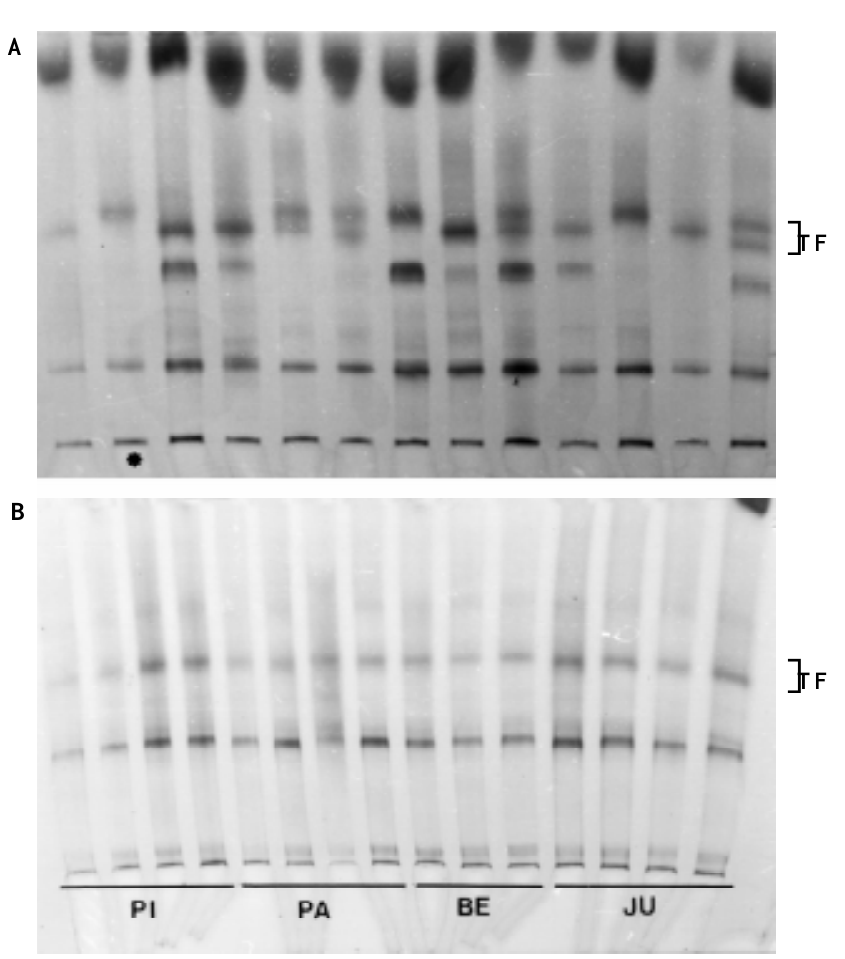
Figure 1 - Electrophoretic patterns of transferrin (TF). A , Allelic variability detected in the Pentecoste stock; *speci- men from the Pirassununga stock. B , Monomorphism detected at Pirassununga (PI), Pacatuba (PA), Betume (BE) and Jundiaí (JU) stocks.